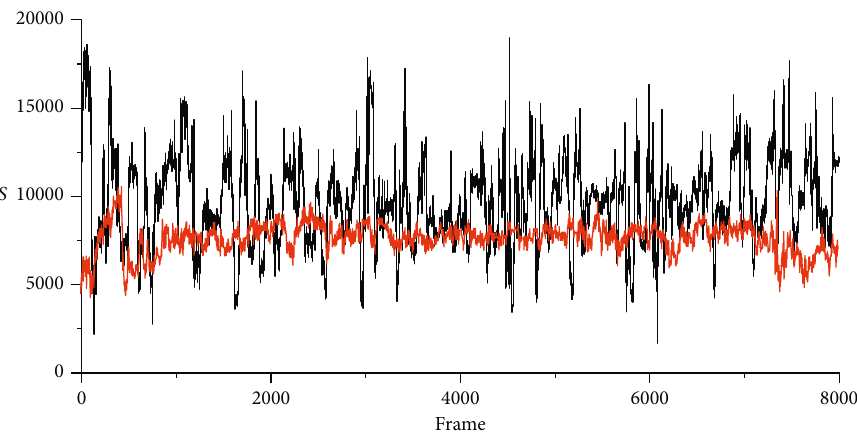
Figure 10: Comparison of elbow area between fatigue and normal